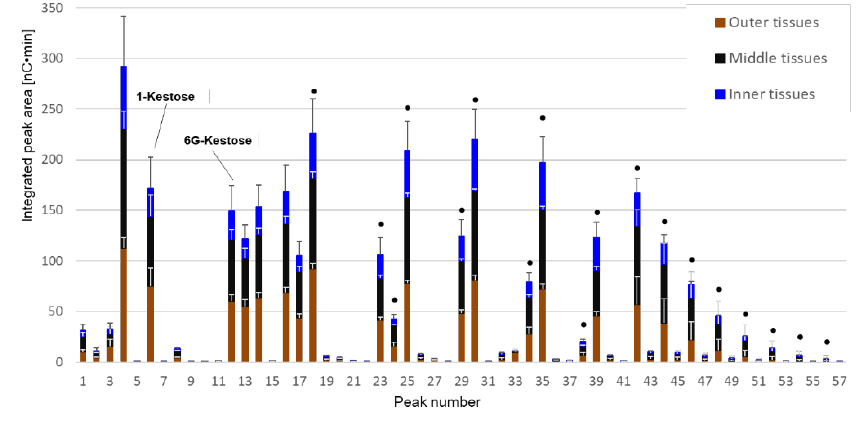
Figure 3. Mean integrated peak areas of oligosaccharide profiles obtained by HPAEC-PAD analysis for the different tissues. Peak numbers refer to annotations listed in Table 1. Mean values and errors were calculated from measurements of the three independent biological replicates. Fructan peaks with increased abundance ratio relative to those of 1-kestose and 6G-kestose for middle and / or inner tissues when compared to outer tissues are highlighted with ( • ) according to the ratios presented in Table 2. Separate levels for the individual tissues are presented in Figure S4.